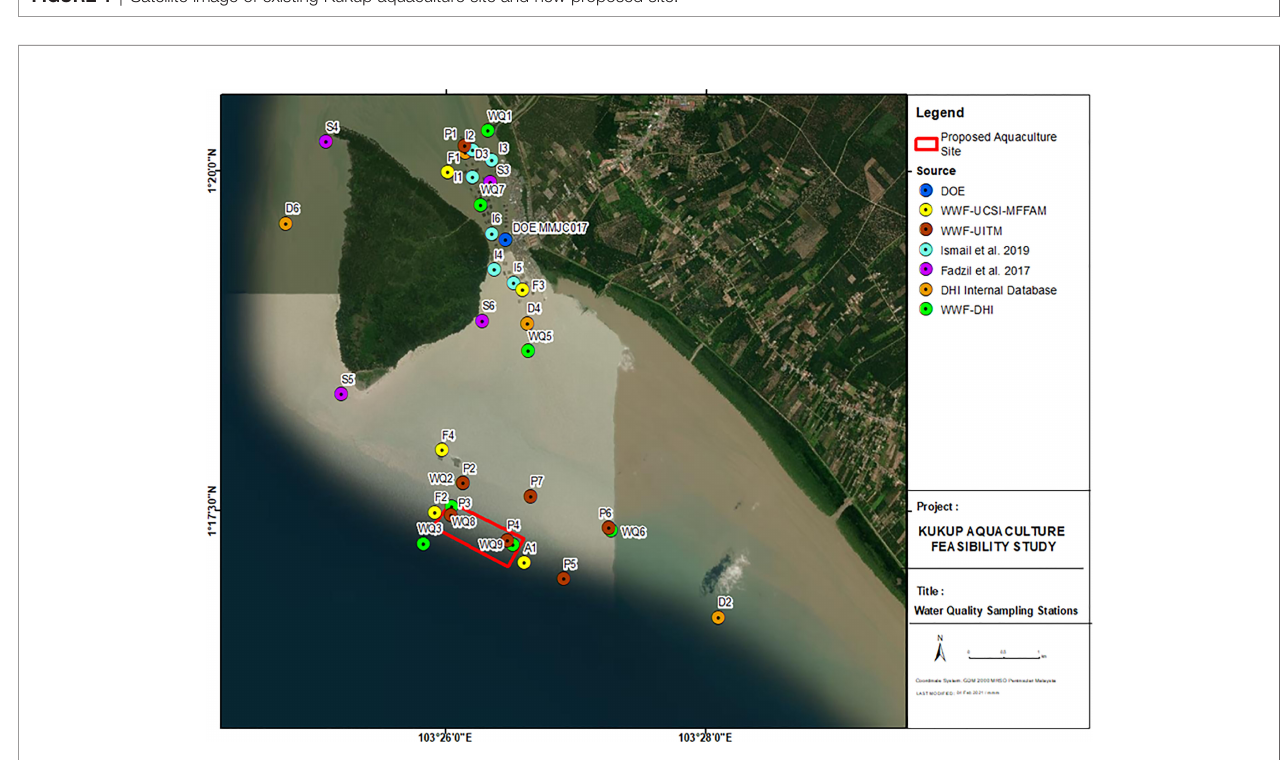
FIGURE 2 | Water quality and marine sediments sampling stations from the respective sources within the existing Kukup aquaculture site, new proposed aquaculture site and surrounding